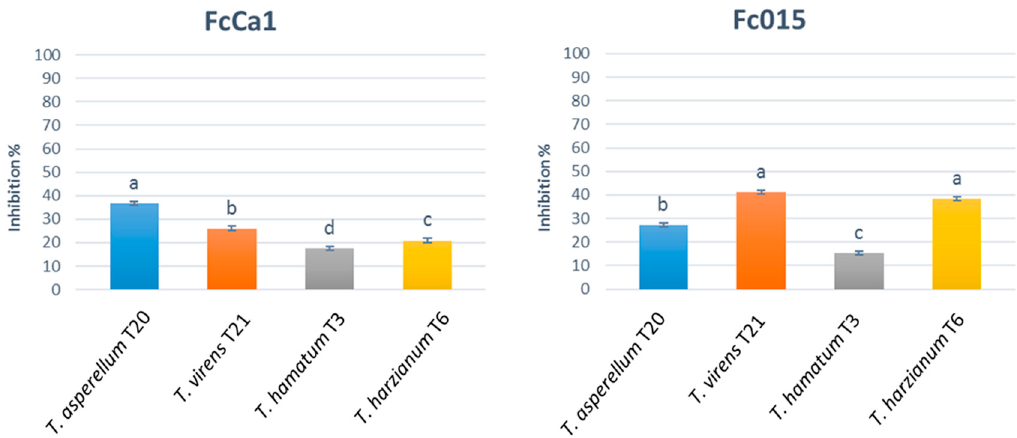
Figure 3. Percent inhibition of F. circinatum (FcCa1 and Fc015) mycelial growth by non-volatile compounds of Trichoderma spp. Different letters indicate significant differences at p < 0.05, according to Tukey’s post-hoc test. Vertical bars indicate SE.